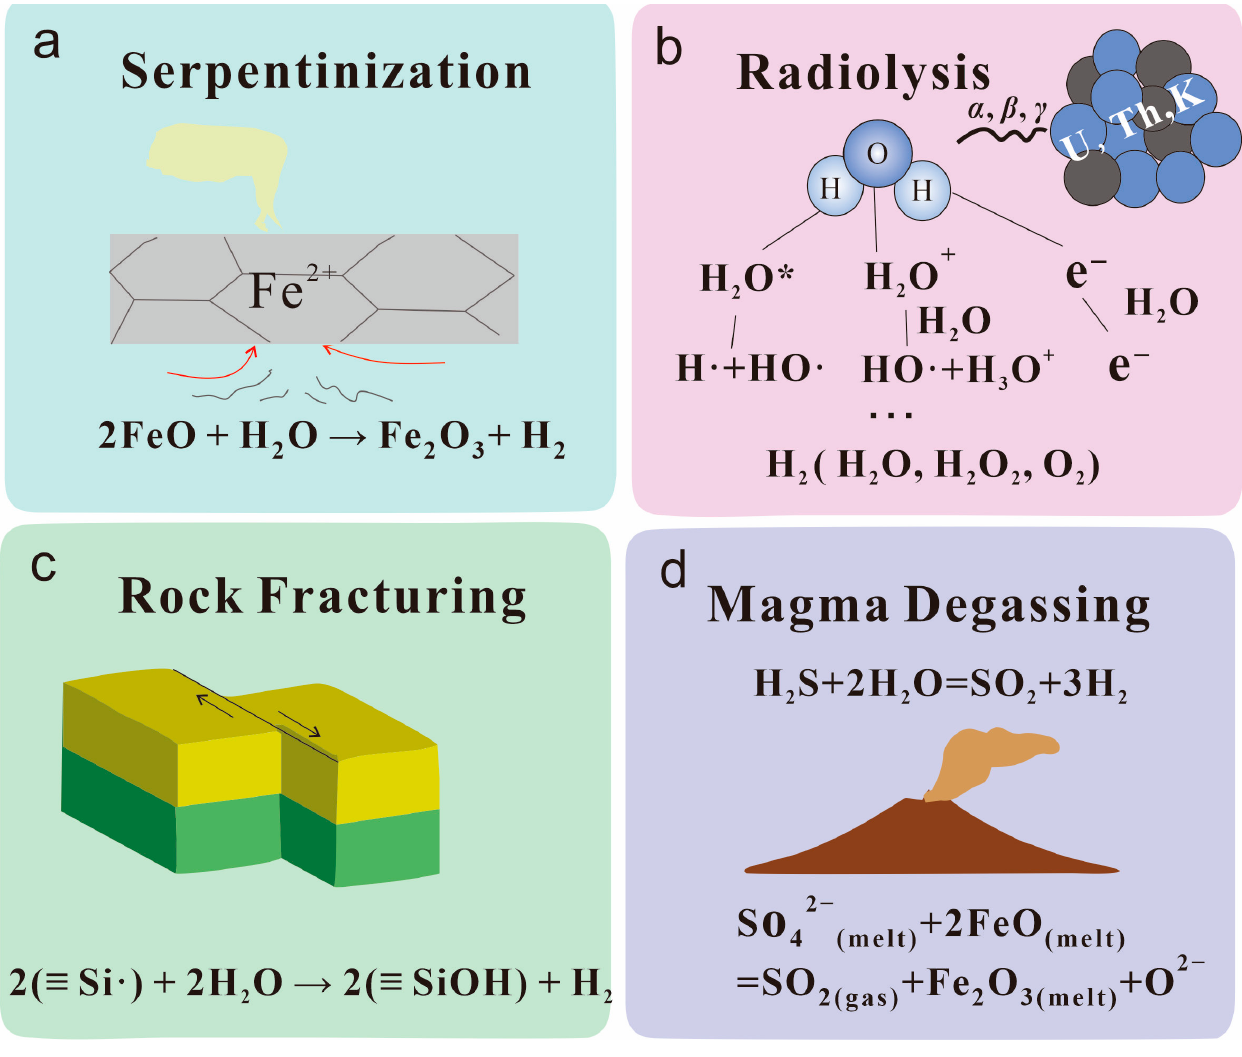
Figure 3. Diagram showing the main sources of hydrogen (modified from [56]). ( a ) Serpentinization of rocks generates hydrogen if water is reduced during the oxidation of ferrous to ferric iron. ( b ) Radiolysis produces hydrogen during splitting of water through radioactive decay. ( c ) Rock fracturing generates hydrogen on the wet surfaces of active faults. ( d ) Volcanoes emit hydrogen when SO 2 is degassed at low pressure.